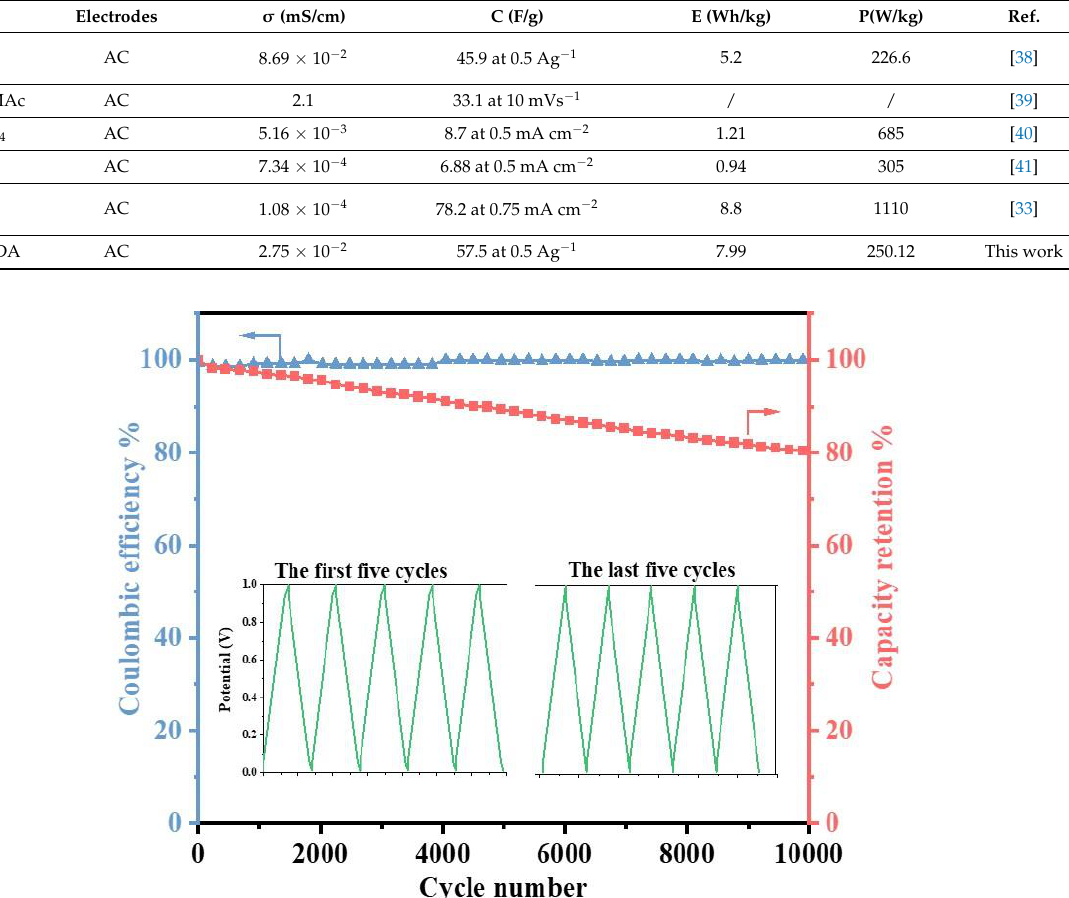
Table 1. Chitosan − based EDLCs reported by other works.